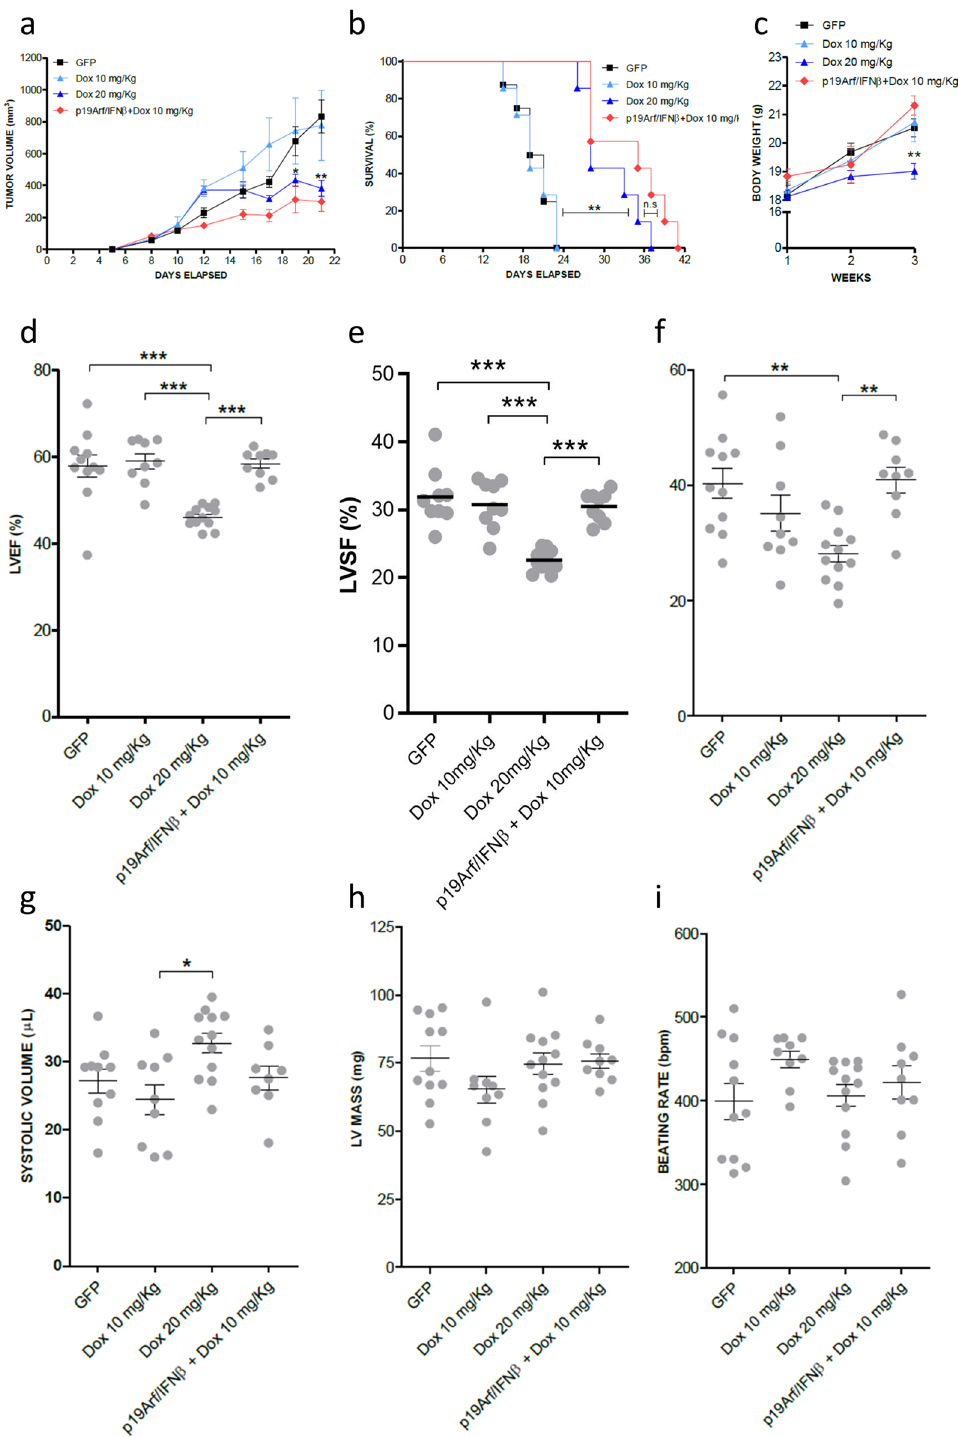
Figure 6. Pre-treatment with p19Arf/IFNβ gene therapy restores efficacy of a sub-therapeutic dose of doxorubicin yet maintains cardiac function. ( a ) Tumor progression curves of established MCA tumors that were treated with 10 or 20 mg/kg of doxorubicin or in the association group, treated with the AdRGD-PG-p19 and AdRGD-PG-IFNβ in situ gene therapy and after 48 h, also treated with 10 mg/kg of doxorubicin. [Two-way Anova and Bonferroni post-test] n = 8 for all groups. ( b ) Survival analysis of mice from ( a ). [Log Rank Mantel- cox test, followed by Wilcoxon post-test]. ( c ) Monitoring of body weight during therapy [Two-way Anova and Bonferroni post-test]. Echocardiogram analysis of ( d ) ejection fraction, ( e ) left ventricular systolic function, ( f ) stroke volume, ( g ) systolic volume, ( h ) left ventricular (LV) mass and ( i ) beating rate of heart 10 days after therapy. n = 8 for each group. [One-way Anova, followed by Tukey’s multiple comparison